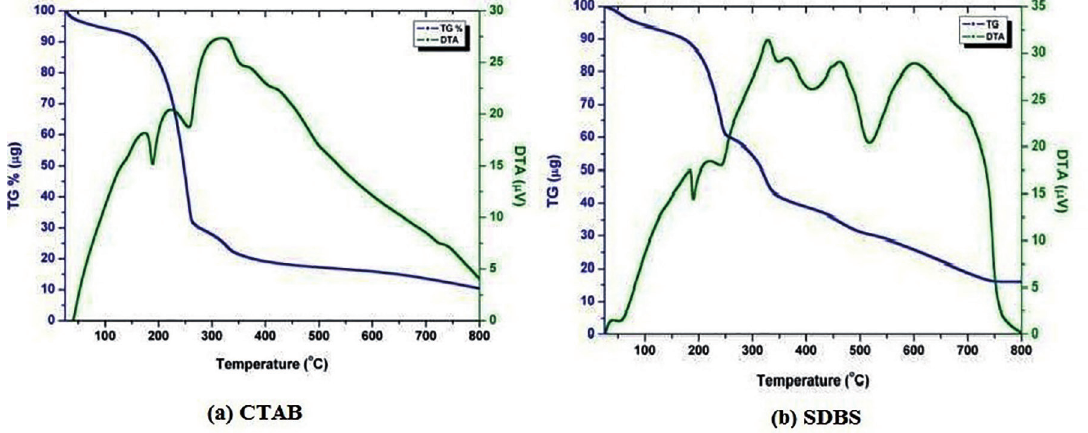
O capped with (a) CTAB (b) SDBS at a heating rate of 10oC/min in static air 2 3